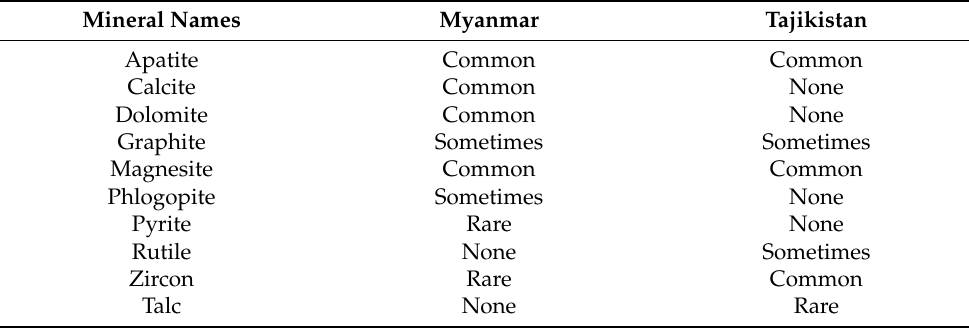
Table 2. Comparison of inclusions in Myanmarese and Tajikistani